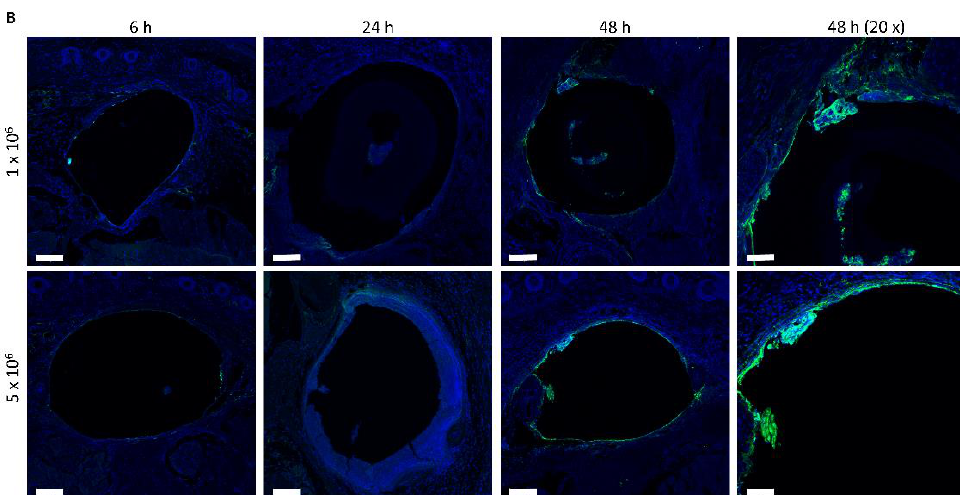
Figure 4. ( A ) Visualization of bacteria at the implantation site after 6 h, 24 h and 48 h. S. aureus were stained in black via gram staining. Bars 20 µm. ( B ) Local endothelium apoptotic tissue damage originating from the infected implants. TUNEL staining of the implantation site after 6 h, 24 h and 48 h with 1 × 10 6 (upper row) as well as 5 × 10 6 (lower row) CFU (colony forming units) infected implant. Apoptotic cells stained in green and nuclei in blue via DAPI. Bars 100 µm for 10× magnification and 50 µm for 20× magnification.